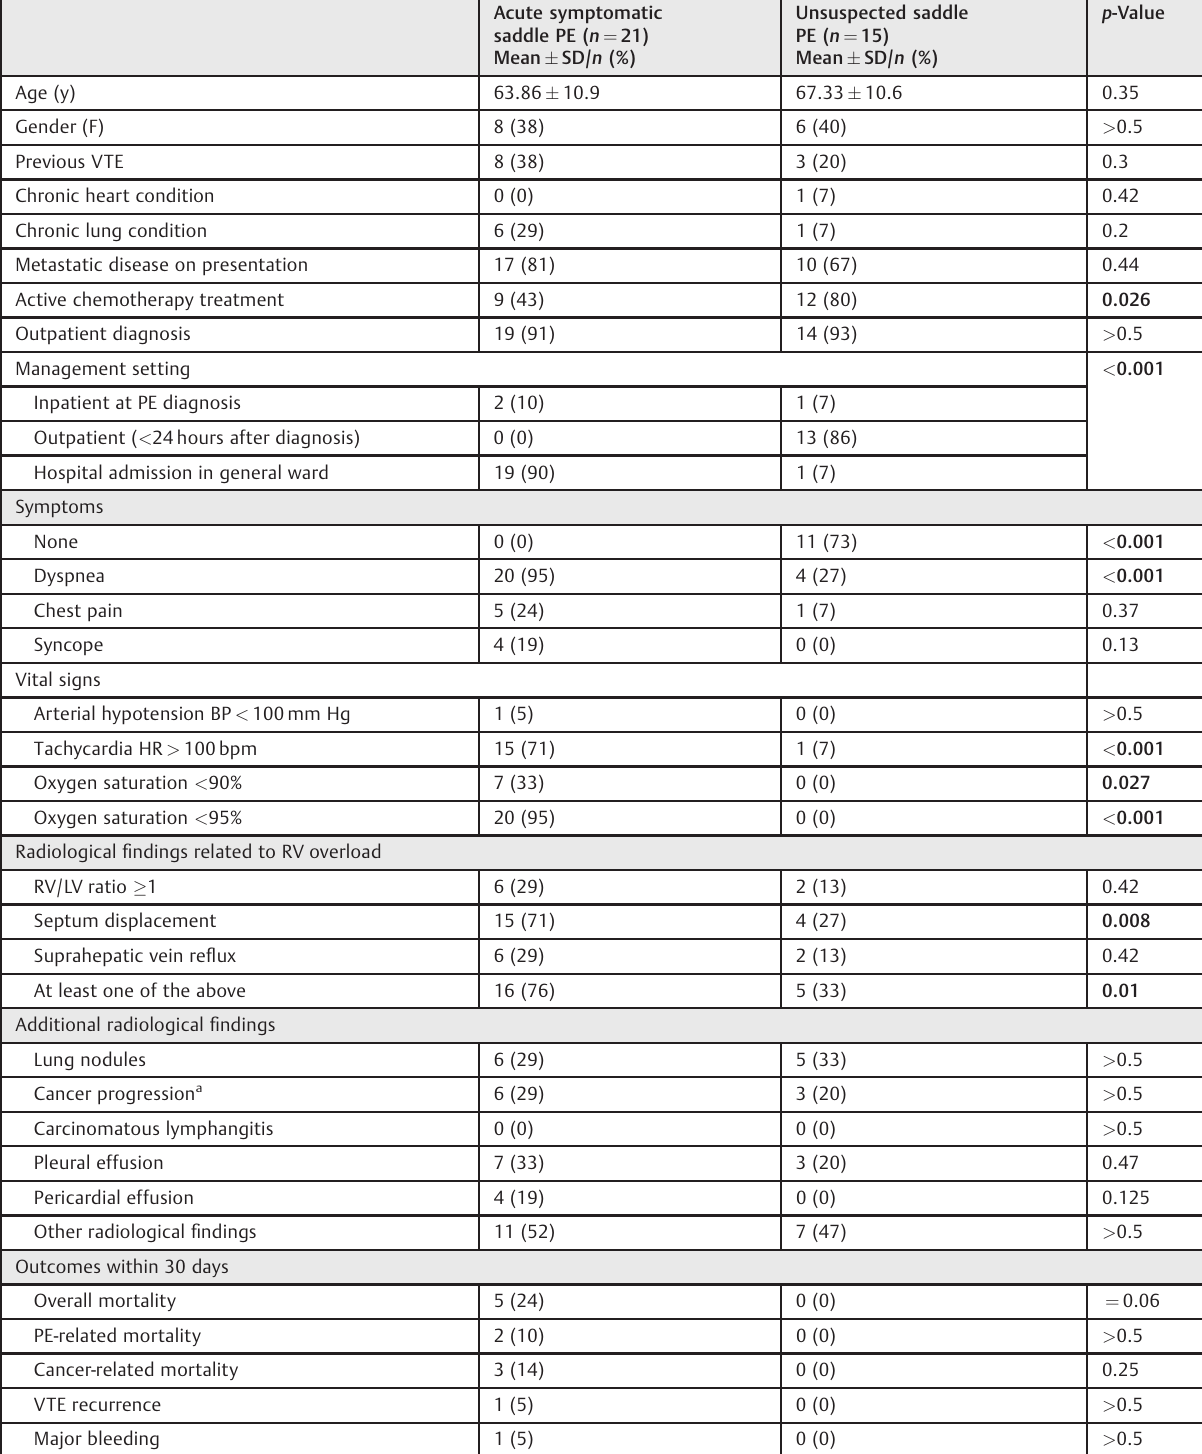
Table 4 Comparison of the main clinical features and outcomes of patients with cancer and saddle pulmonary embolism according to acute symptomatic versus unsuspected